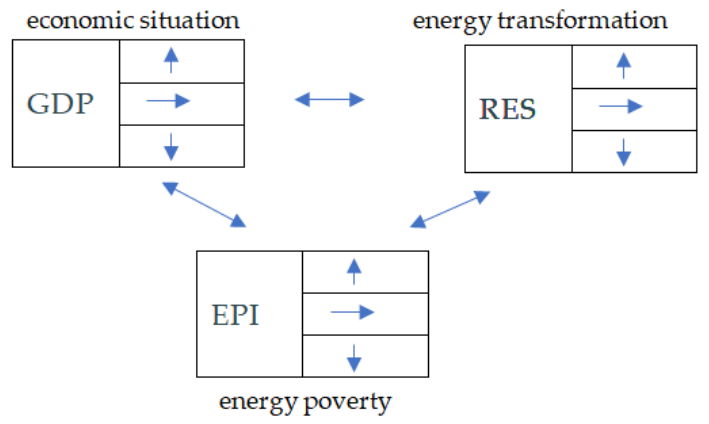
Figure 10. Scenario framework. Source: own prepared.